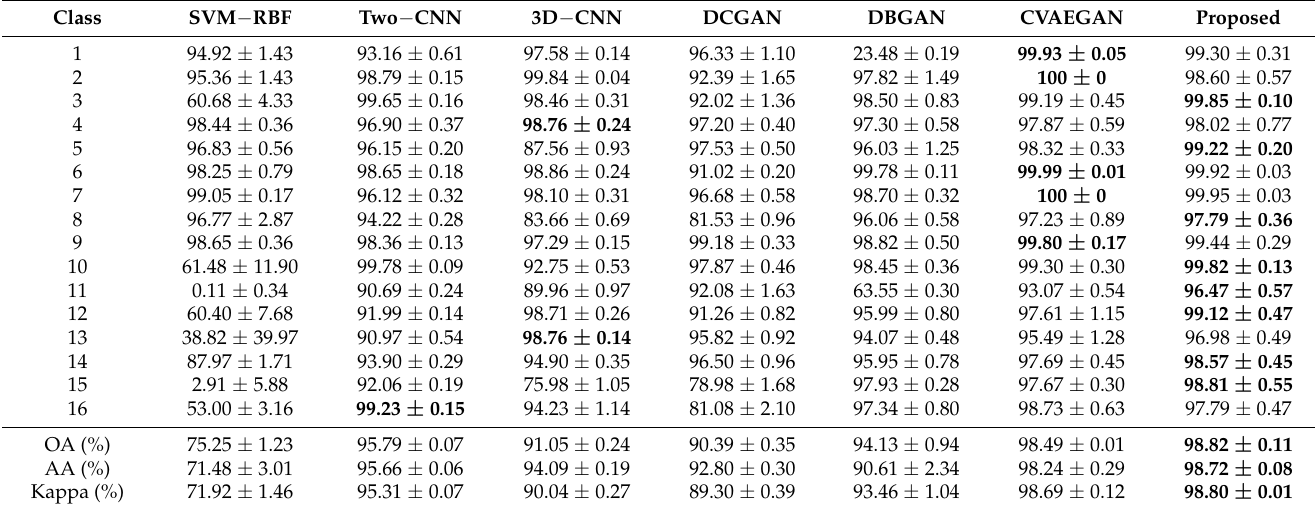
Table 11. Classification results on the Salinas data